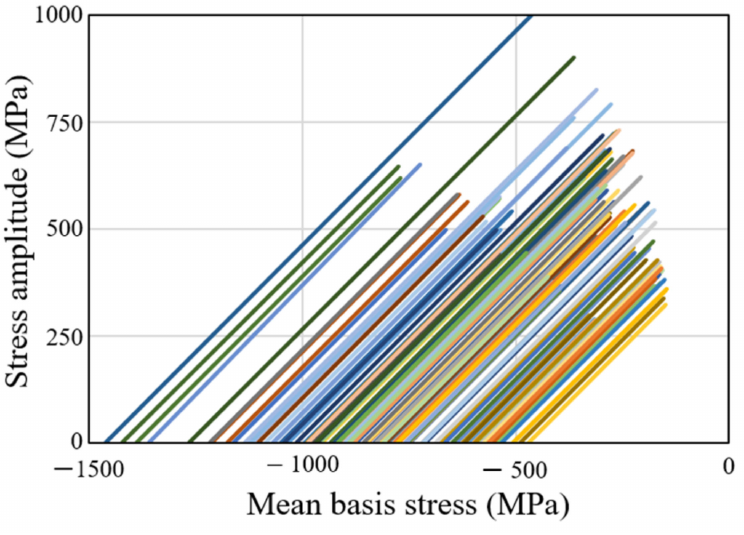
Figure 6. Cyclic stress features of the prestressed die insert